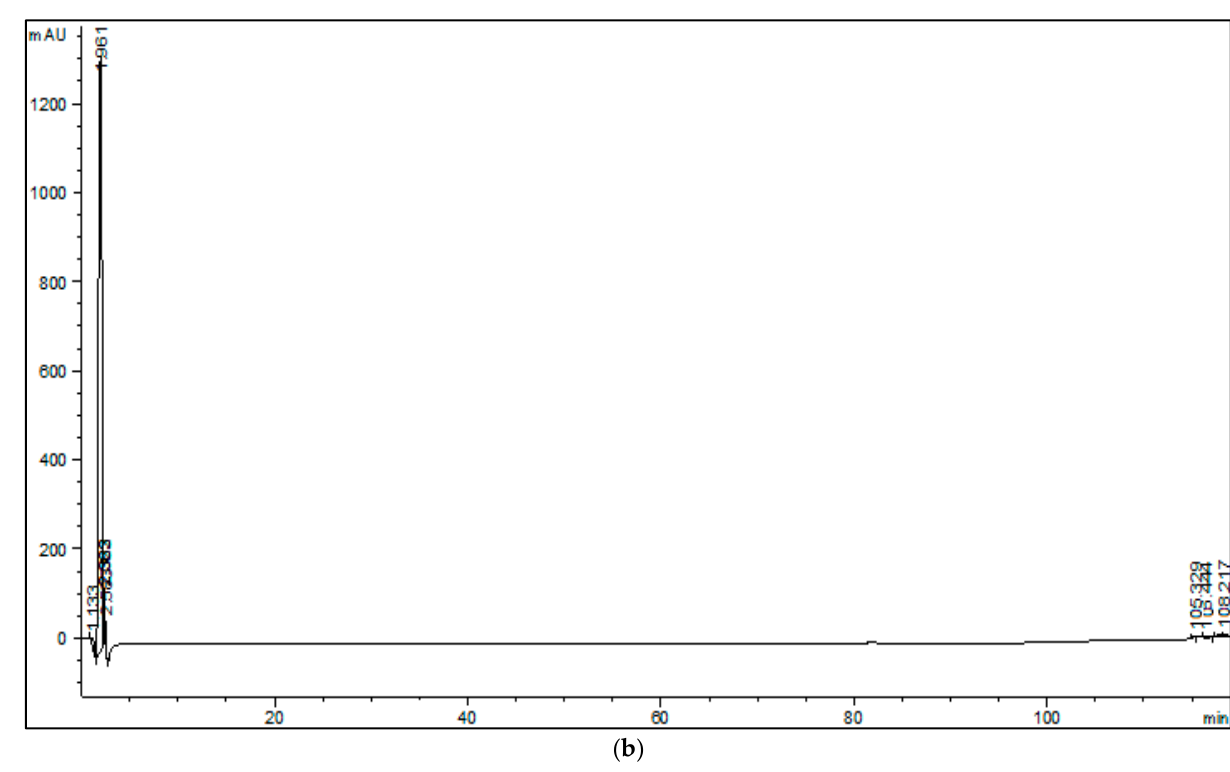
Figure 1. Chromatograms corresponding to the NPN fraction. ( a ) Chromatogram of the first ripening day. ( b ) Chromatogram of the last ripening day.